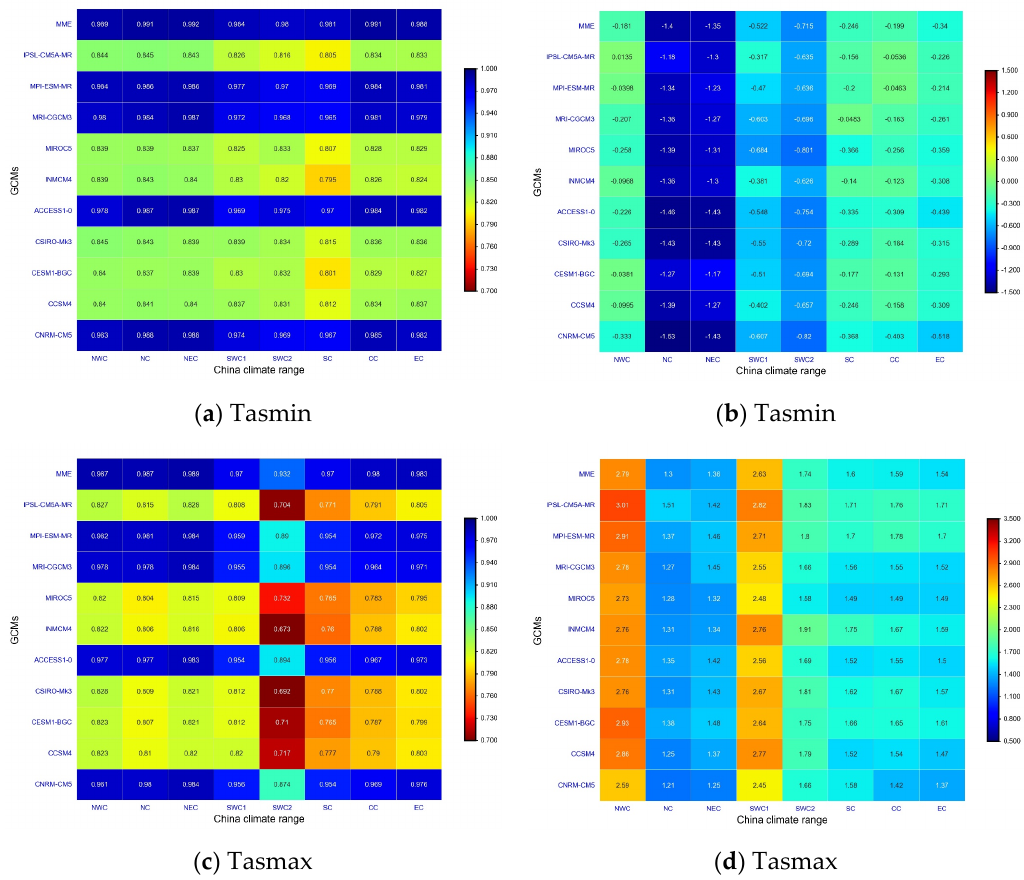
Figure 2. Correlation coefficient ( a , c ) and mean error (ME) (unit: C) ( b , d ) between monthly Tasmin (first row) / Tasmax (bottom row) from the Institute of Tibetan Plateau Research, Chinese Academy of Science (ITPCAS) and simulations from Coupled Model Intercomparison Project Phase 5 (CMIP5) models as well as the multimodel ensemble (MME) over eight climate regions from 1979–2000.